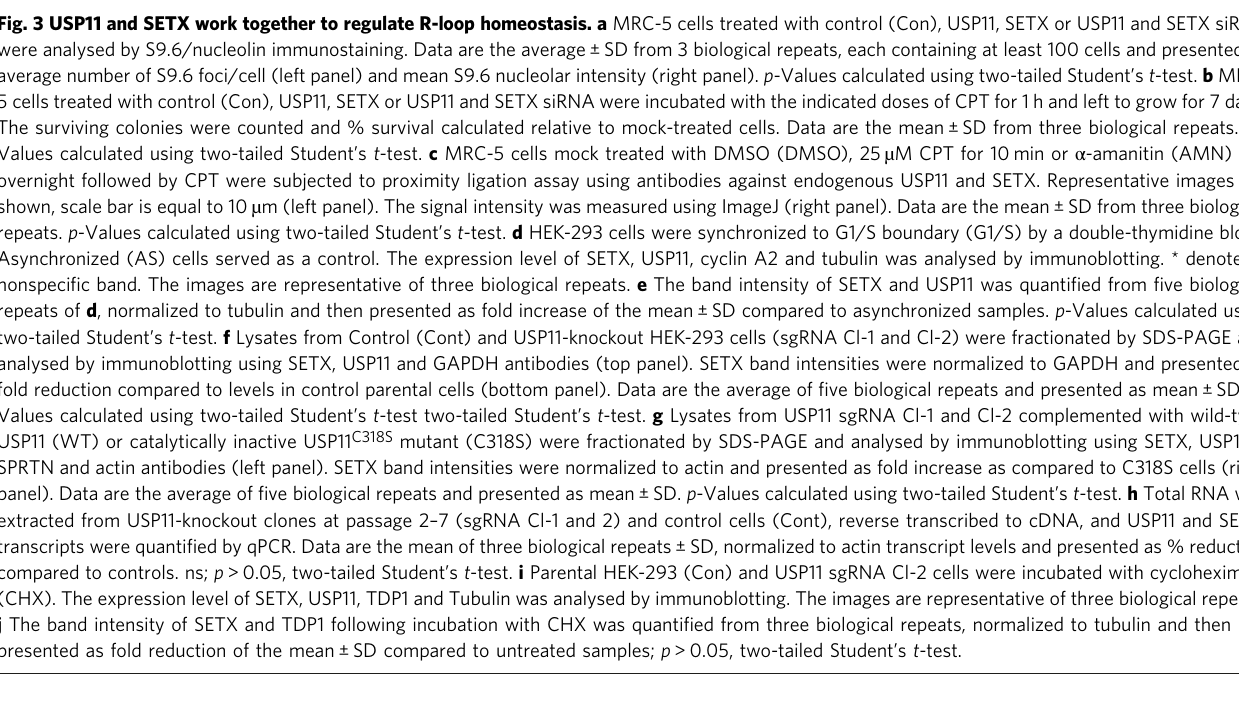
Fig. 3 USP11 and SETX work together to regulate R-loop homeostasis. a MRC-5 cells treated with control (Con), USP11, SETX or USP11 and SETX siRNA were analysed by S9.6/nucleolin immunostaining. Data are the average ± SD from 3 biological repeats, each containing at least 100 cells and presented as average number of S9.6 foci/cell (left panel) and mean S9.6 nucleolar intensity (right panel). p -Values calculated using two-tailed Student ’ s t -test. b MRC- 5 cells treated with control (Con), USP11, SETX or USP11 and SETX siRNA were incubated with the indicated doses of CPT for 1 h and left to grow for 7 days. The surviving colonies were counted and % survival calculated relative to mock-treated cells. Data are the mean ± SD from three biological repeats. p - Values calculated using two-tailed Student ’ s t -test. c MRC-5 cells mock treated with DMSO (DMSO), 25 µ M CPT for 10 min or α -amanitin (AMN) overnight followed by CPT were subjected to proximity ligation assay using antibodies against endogenous USP11 and SETX. Representative images are shown, scale bar is equal to 10 µ m (left panel). The signal intensity was measured using ImageJ (right panel). Data are the mean ± SD from three biological repeats. p -Values calculated using two-tailed Student ’ s t -test. d HEK-293 cells were synchronized to G1/S boundary (G1/S) by a double-thymidine block. Asynchronized (AS) cells served as a control. The expression level of SETX, USP11, cyclin A2 and tubulin was analysed by immunoblotting. * denotes a nonspeci fi c band. The images are representative of three biological repeats. e The band intensity of SETX and USP11 was quanti fi ed from fi ve biological repeats of d , normalized to tubulin and then presented as fold increase of the mean ± SD compared to asynchronized samples. p -Values calculated using two-tailed Student ’ s t -test. f Lysates from Control (Cont) and USP11-knockout HEK-293 cells (sgRNA Cl-1 and Cl-2) were fractionated by SDS-PAGE and analysed by immunoblotting using SETX, USP11 and GAPDH antibodies (top panel). SETX band intensities were normalized to GAPDH and presented as fold reduction compared to levels in control parental cells (bottom panel). Data are the average of fi ve biological repeats and presented as mean ± SD. p - Values calculated using two-tailed Student ’ s t -test. g Lysates from USP11 sgRNA Cl-1 and Cl-2 complemented with wild-type USP11 (WT) or catalytically inactive USP11 C318S mutant (C318S) were fractionated by SDS-PAGE and analysed by immunoblotting using SETX, USP11, SPRTN and actin antibodies (left panel). SETX band intensities were normalized to actin and presented as fold increase as compared to C318S cells (right panel). Data are the average of fi ve biological repeats and presented as mean ± SD. p -Values calculated using two-tailed Student ’ s t -test. h Total RNA was extracted from USP11-knockout clones at passage 2 – 7 (sgRNA Cl-1 and 2) and control cells (Cont), reverse transcribed to cDNA, and USP11 and SETX transcripts were quanti fi ed by qPCR. Data are the mean of three biological repeats ± SD, normalized to actin transcript levels and presented as % reduction compared to controls. ns; p > 0.05, two-tailed Student ’ s t -test. i Parental HEK-293 (Con) and USP11 sgRNA Cl-2 cells were incubated with cycloheximide (CHX). The expression level of SETX, USP11, TDP1 and Tubulin was analysed by immunoblotting. The images are representative of three biological repeats. j The band intensity of SETX and TDP1 following incubation with CHX was quanti fi ed from three biological repeats, normalized to tubulin and then presented as fold reduction of the mean ± SD compared to untreated samples; p > 0.05, two-tailed Student ’ s t